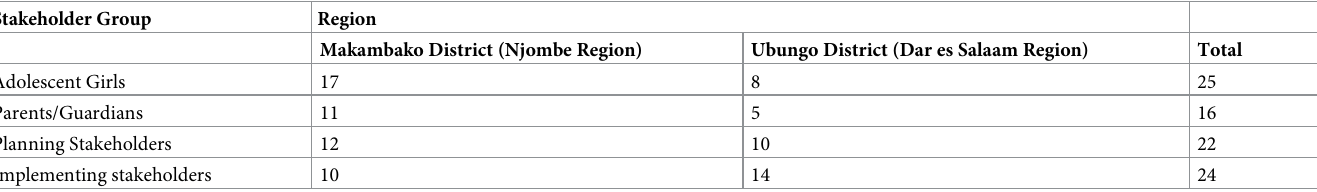
Table 1. Stakeholders interviewed by group (n =